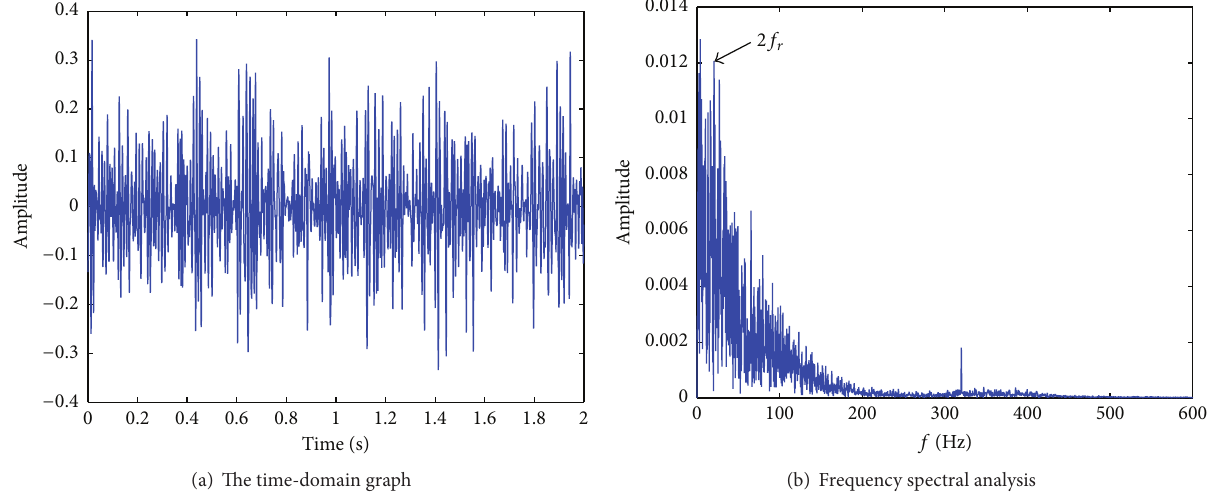
Figure 10: The result obtained by wavelet denoising method.